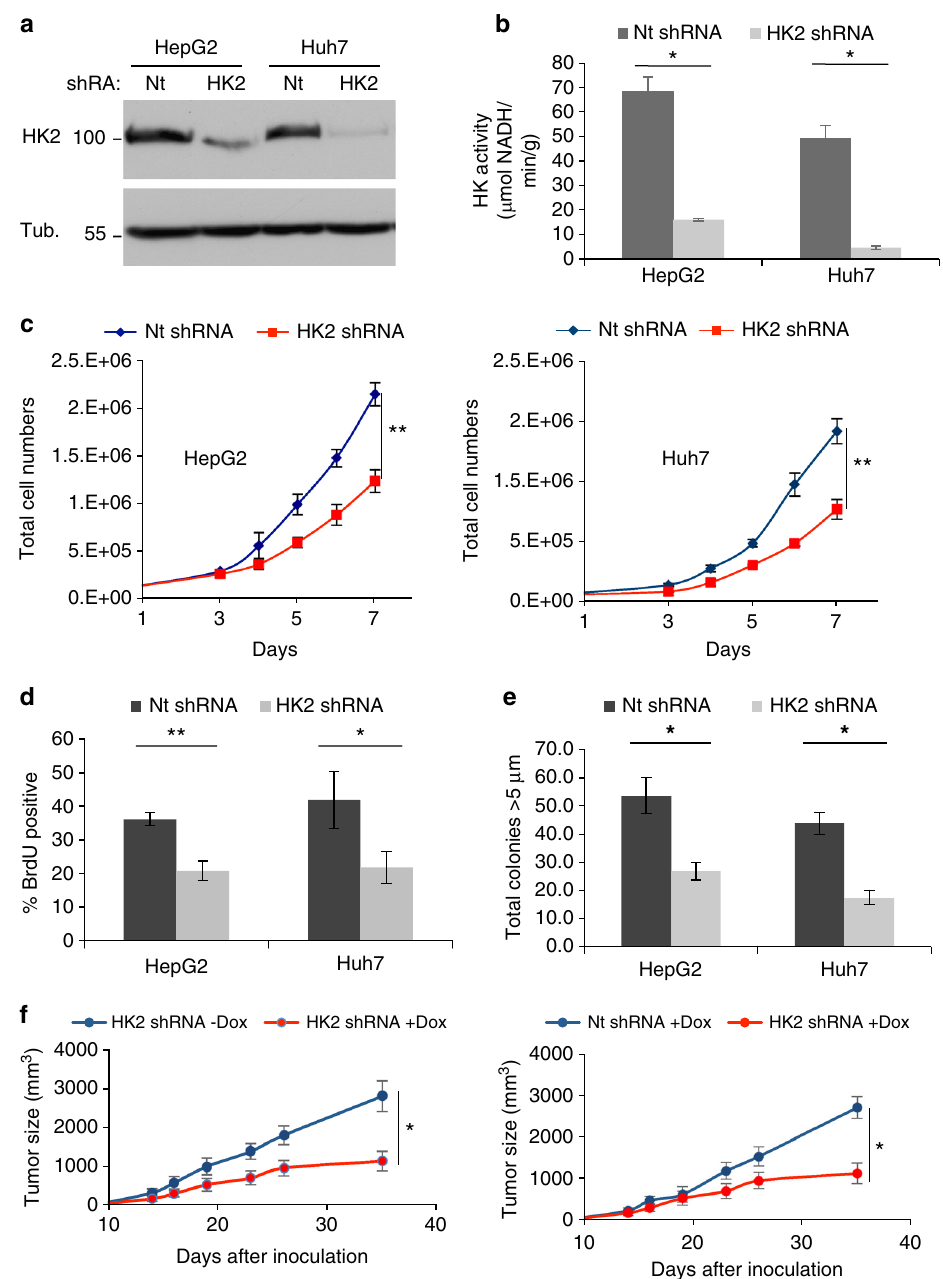
Fig. 2 Effect of HK2 knockdown on tumorigenicity of human HCC cells. a Immunoblot analysis of inducible HK2 KD in HepG2 and Huh7 cells. b In vitro hexokinase activity assays upon inducible HK2 KD. c Cell proliferation curves. d BrdU incorporation analysis. Bar graphs show the percentage of BrdU- positive cells. e Anchorage-independent growth on soft agar. The cells were exposed to Dox for 3 days prior to analysis and maintained in Dox throughout the analyses. Bar graphs show the number of colonies larger than 5 μ m. f In vivo tumor growth. Cells were inoculated into mice; after tumor detection, mice were fed either regular chow diet or with a Dox-infused diet. The left panel shows tumor growth of the Huh7 cells with inducible HK KD in either the absence or presence of Dox, and the right panel shows the tumor growth of the inducible HK KD in the presence of Dox compared to tumor growth of control cells in the presence of Dox ( n = 6). Nt and HK2 shRNA indicate Dox-inducible non-targeting and HK2 shRNA, respectively. See Methods for experimental details. The results represent mean ± SEM, * p < 0.05, ** p < 0.01, by Student ’ s t